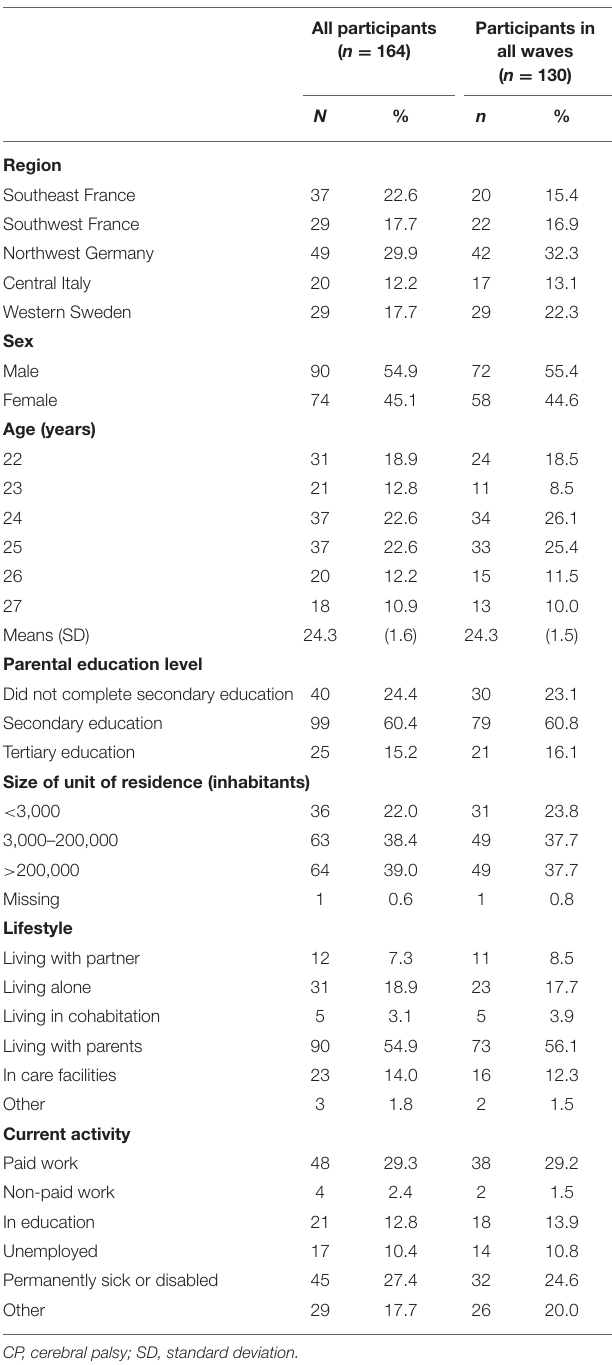
TABLE 1 | Sociodemographic characteristics of young adults with CP: SPARCLE cohort—France, Germany, Italy, and Sweden.